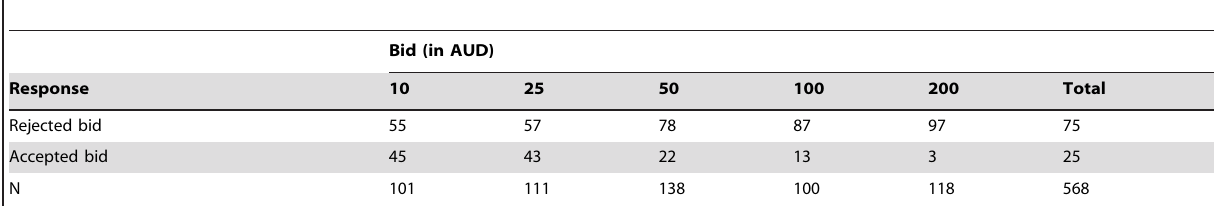
Table 5. Distribution of responses to the WTP bids (in %); N=number of respondents offered the bid.